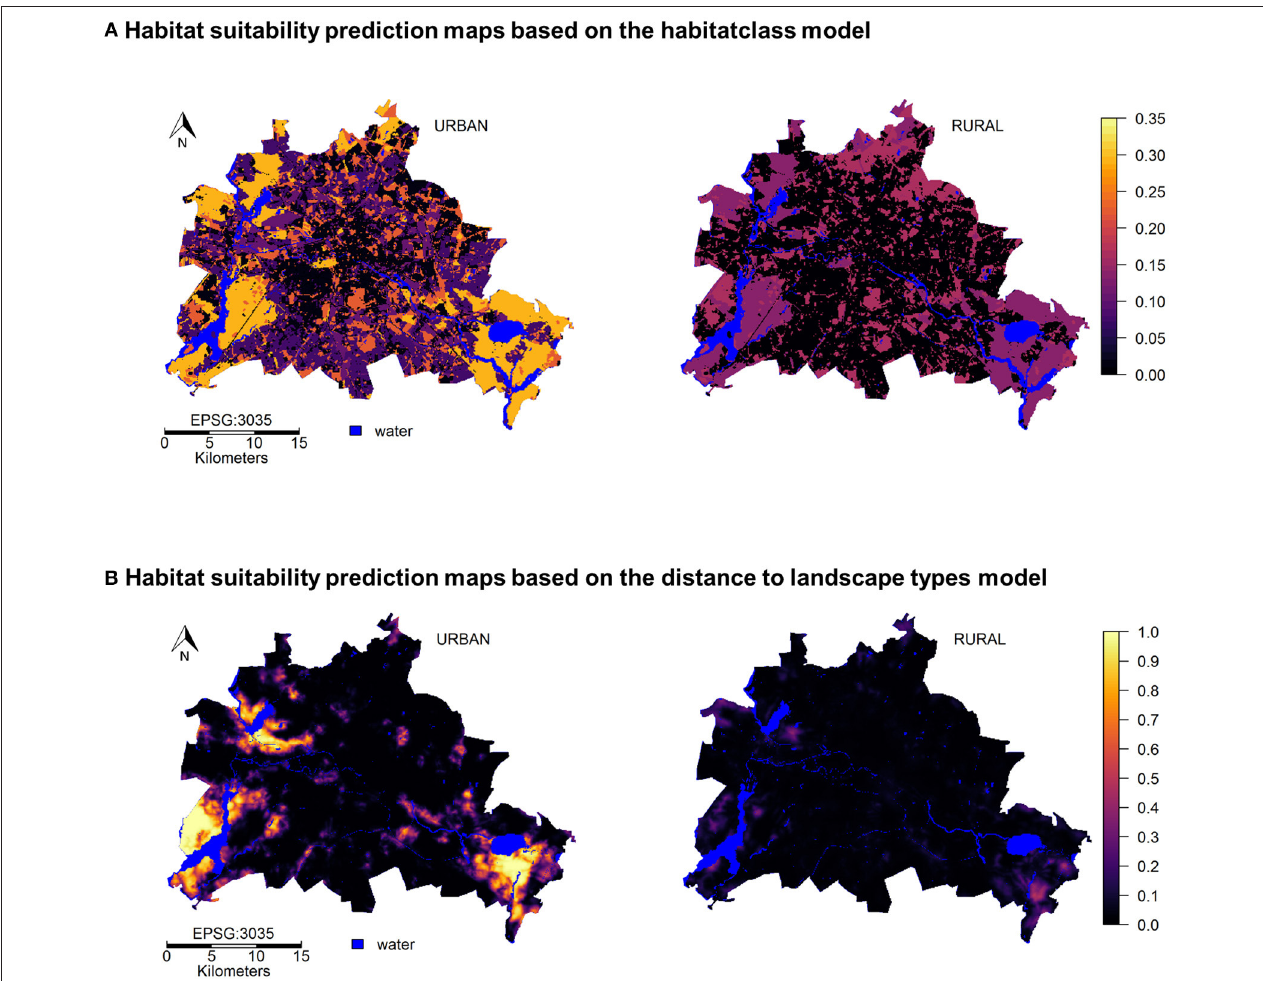
FIGURE 4 | Prediction maps showing suitable habitats within Berlin from the perspective of urban and rural wild boar. (A) Habitat suitability from predicted from GLMMs with habitat class. (B) Habitat suitability predicted from GLMMS with distance variables and